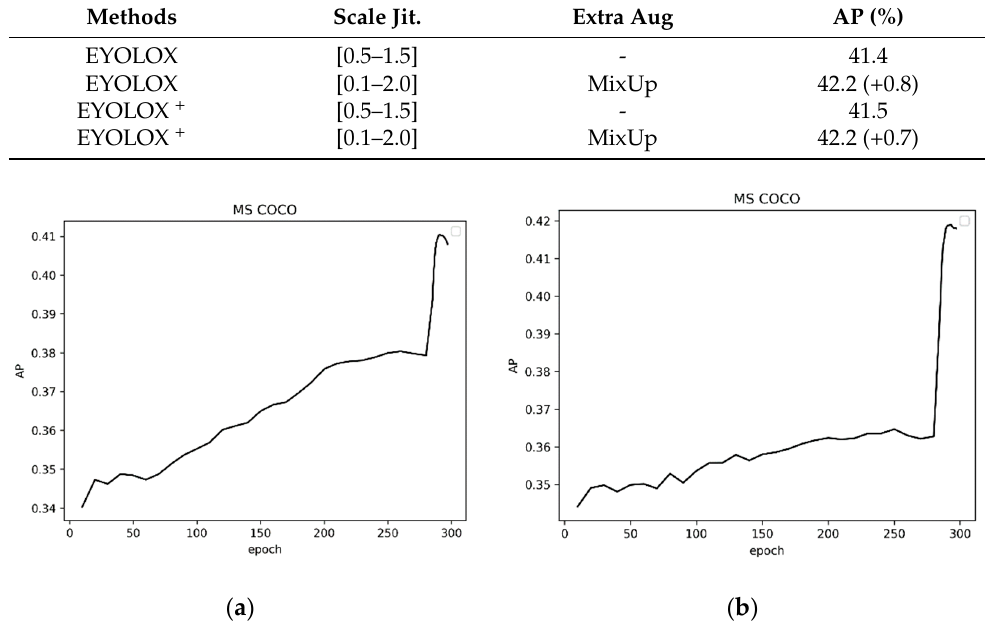
Figure 7. Comparison of training AP changes for two data enhancement strategies applied to EYOLOX. ( a ) does not use MixUp and reduces the mosaic dithering range. ( b ) uses MixUp and increases the mosaic dithering range.